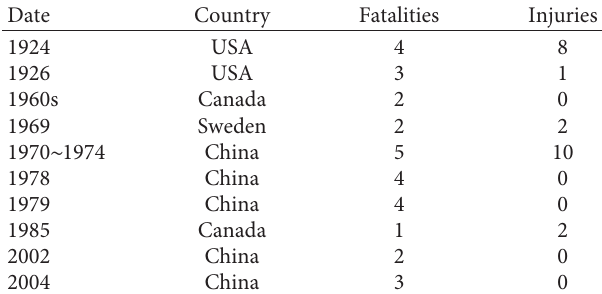
Table 1: Reported cases of sulfide dust